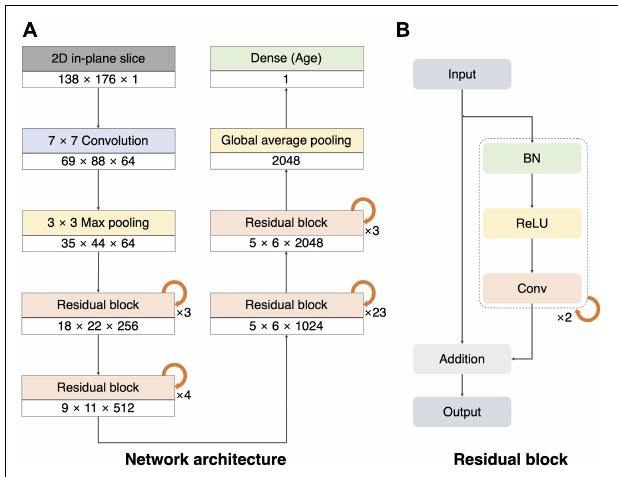
FIGURE 1 | Architecture of our 2D single-channel convolutional neural network (CNN). (A) Architecture of the ResNet101V2 model. The size and number of the feature maps used in each step are listed at the bottom of the block (width × height × number of feature maps). Global average pooling compresses the final feature maps to a 2048 one-dimensional array. The dense layer was used to make a single regression output (brain age). (B) Residual block with batch normalization (BN), rectified linear unit (ReLU), and convolution (Conv).